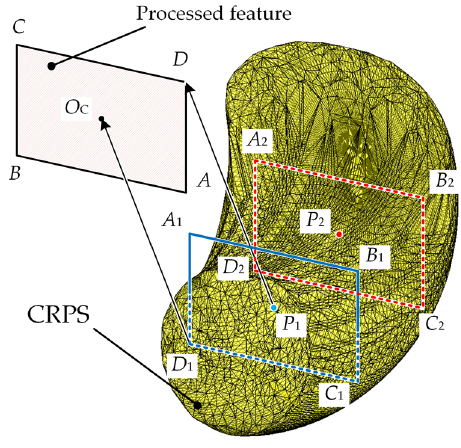
Figure 6. Model of reachability